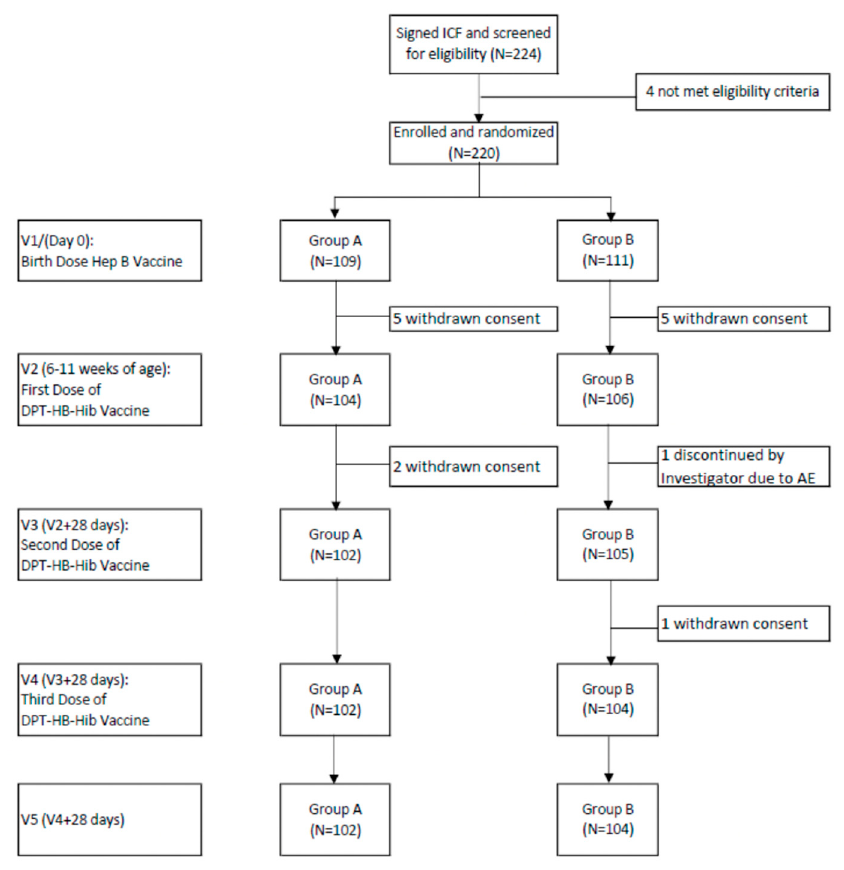
Figure 1. Participant’s flowchart.